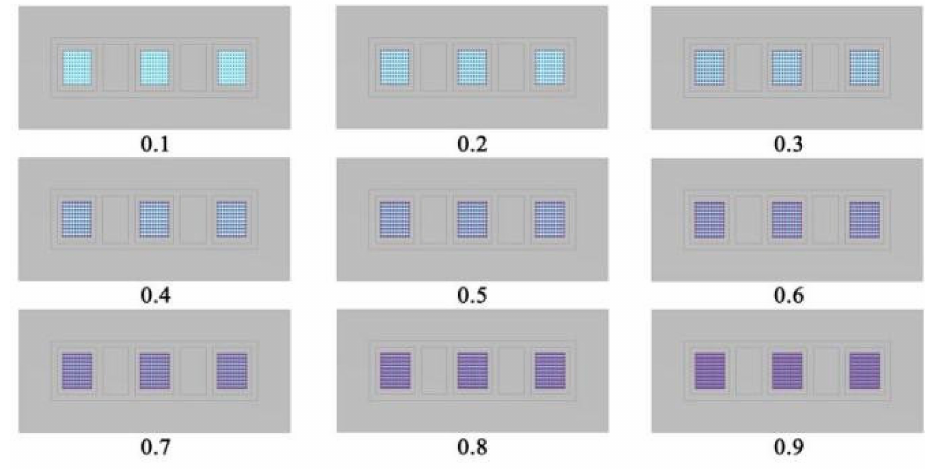
Figure 13. Fabric coverage diagram.